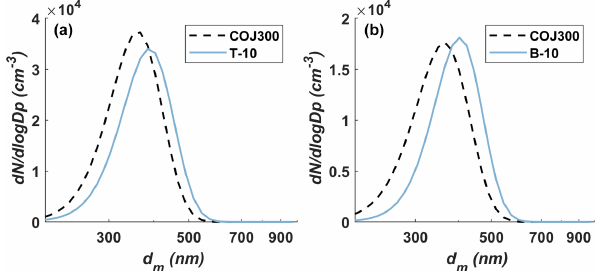
Figure 2. The modal diameter shift of 350nm COJ300 BC particles after toluene (a) and β -caryophyllene (b) SOA coating. The dashed and solid lines are the fitted curves for bare uncoated and coated particles,